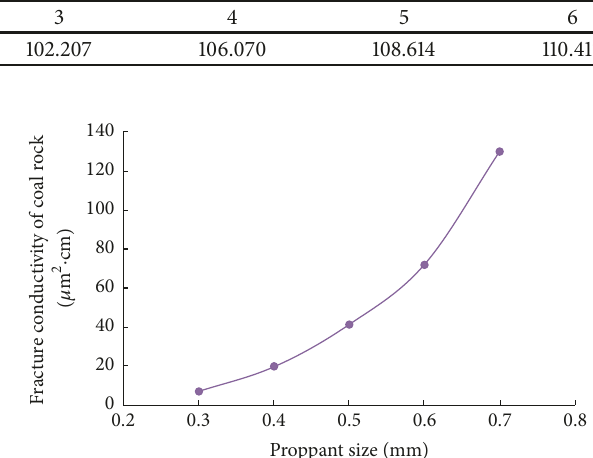
Figure 12: Relationship curveof fractureconductivity and proppant